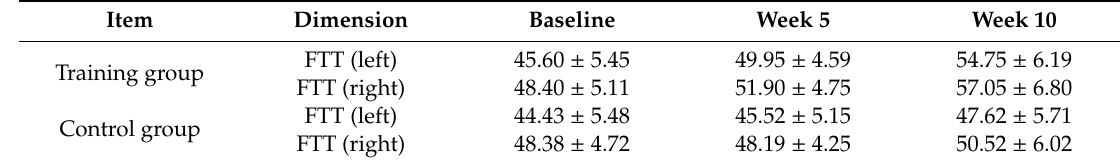
Table 7. FTT scores before and after intervention ( N = 41, and X ± SD).